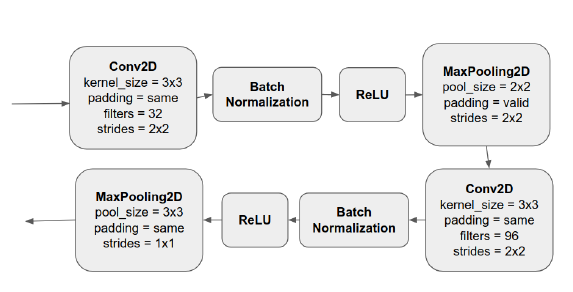
Figure 5. Feature extractor for the MM-HR model shown in Figure 4.